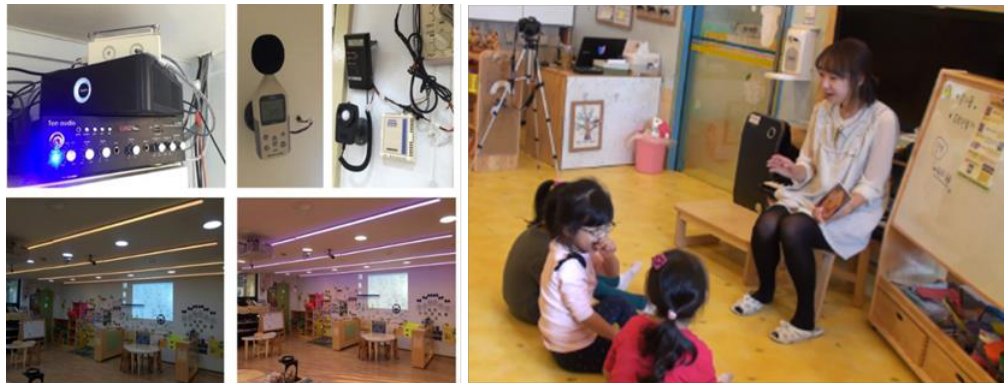
Figure 1. Emotion control experiment in a kindergarten. Left four photos show the sensors attached at the kindergarten, and right one shows a classroom with one teacher and three children.